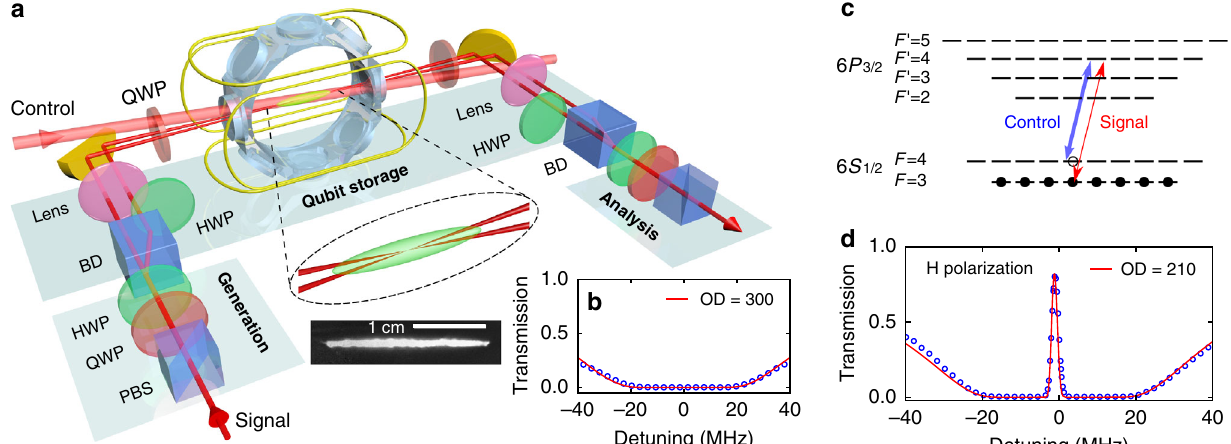
Fig. 1 Quantum memory for polarization qubits in a multiplexed large OD atomic cloud. a A polarization qubit is encoded via a quarter (QWP) and a half wave plate (HWP) and converted into a dual-rail qubit with a beam displacer (BD). The orthogonally polarized beams, separated by 4 mm, are then mapped into an elongated ensemble of laser-cooled cesium atoms prepared in a 2D magneto-optical trap in a glass chamber. The spatial multiplexing is realized by focusing the two parallel paths into the 2.5-centimeter-long ensemble with a small crossing angle of 0.5° in order to preserve a large OD for each mode, an essential but challenging feature. A single control beam propagates with an angle of 1° relative to the signal modes in the plane of symmetry. b A large OD of 300 is obtained. The blue points correspond to the experimental data while the red solid line gives the theoretical fi t. c Energy levels of the Cs D 2 line involved in the EIT scheme. The atoms are prepared in F = 3 and populate all the Zeeman levels. Signal and control fi elds have the same circular polarization to avoid residual absorption. A comprehensive model is derived to take into account all the atomic levels, including the excited levels out of resonance. This model allows to understand the fundamental limits for storage and retrieval in such a setting, as described in the text. d Typical EIT spectrum as a function of the signal detuning when the control beam is kept on resonance. The red solid line corresponds to the full